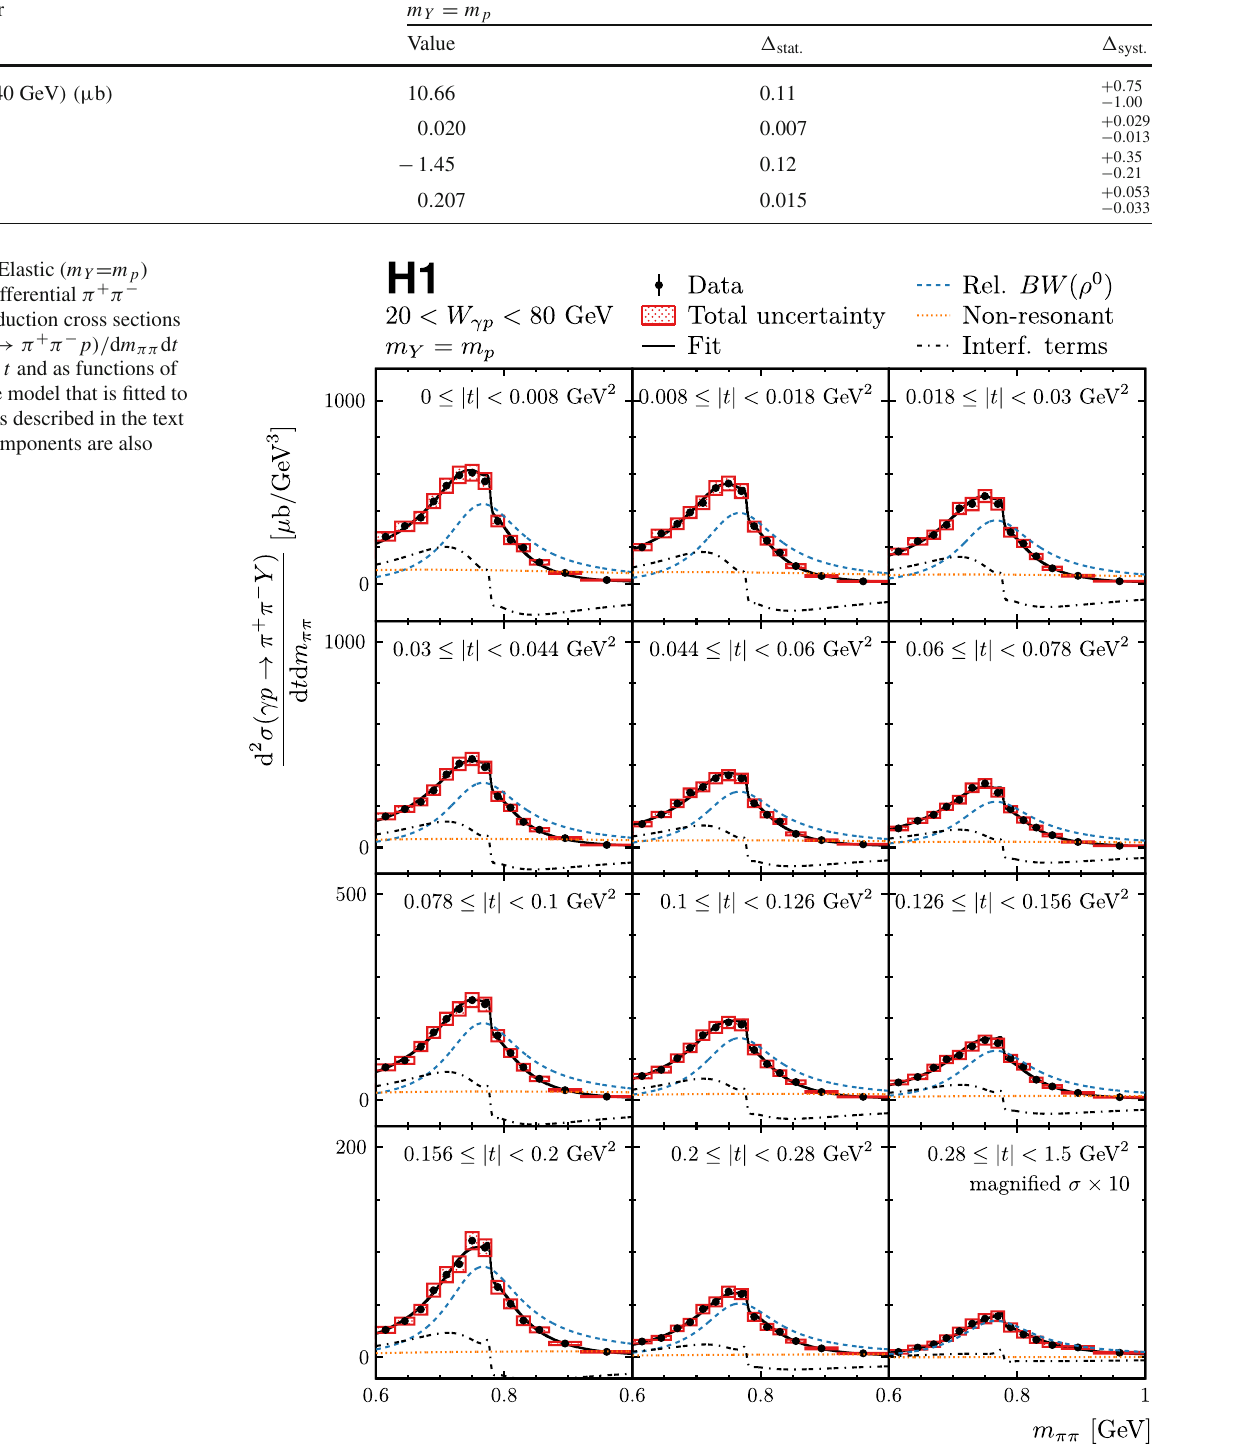
tematic uncertainties are given. A full uncertainty breakdown and sta- tistical correlations are provided [77]. The corresponding fit is shown